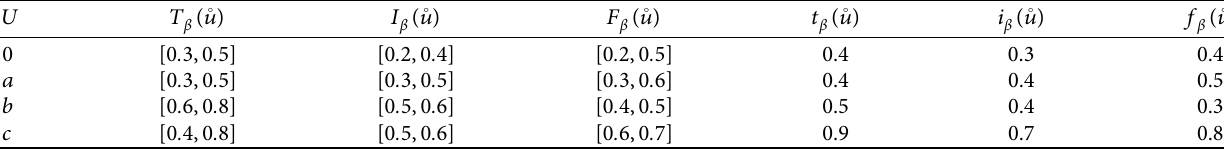
Table 1: Neutrosophic cubic set β of U.